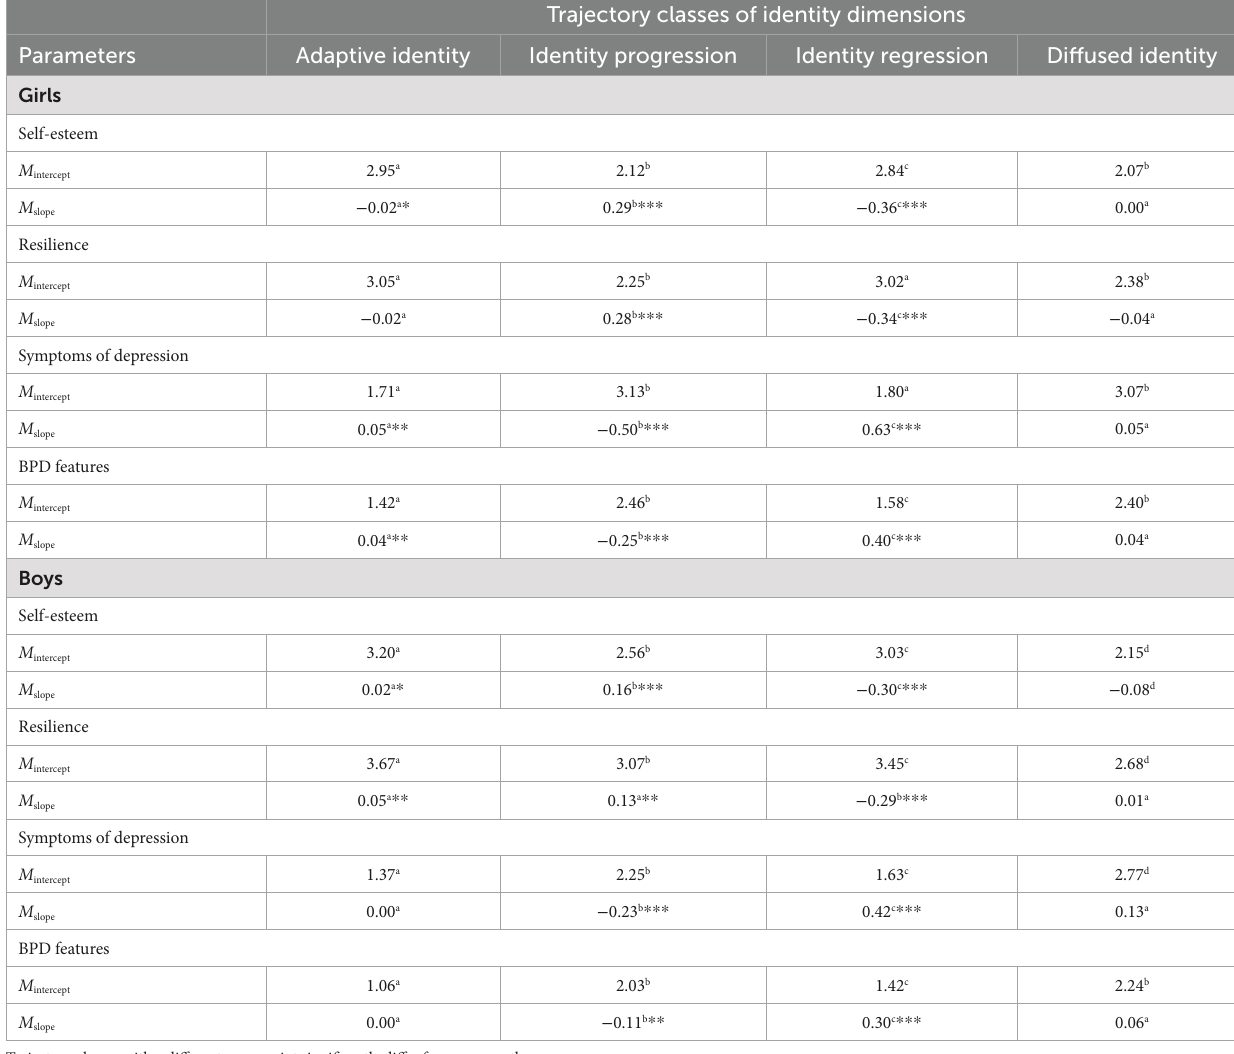
TABLE 6 Baseline parameter estimates of multi-group Latent Growth Curve Modeling in girls and